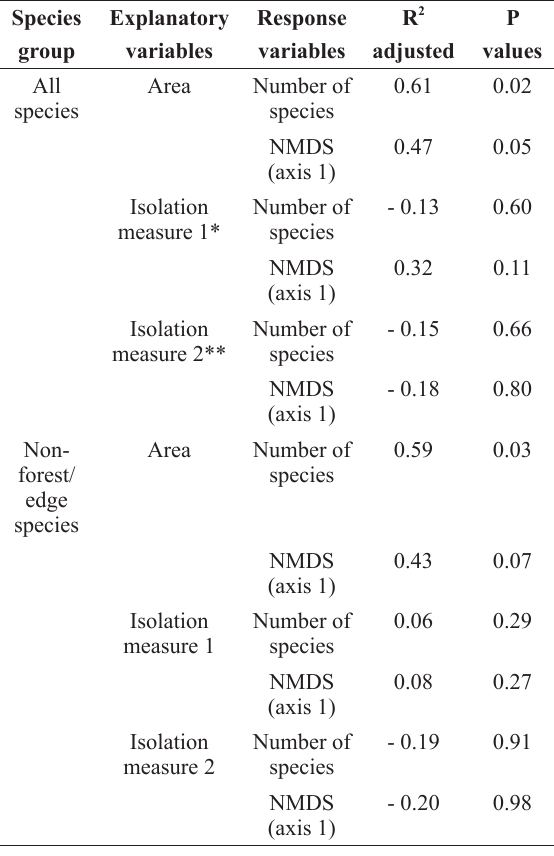
Results of simple regression analysis testing the relationships between area and isolation metrics of cangas and bird species diversity and composition. Sample size for all analysis was seven